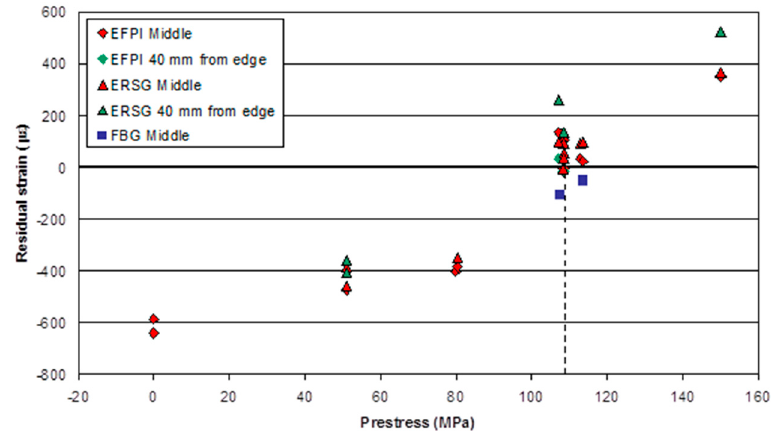
Figure 20. The measured residual strains in the composites produced in this study as a function of the pre-stress levels that were applied to the prepregs prior to